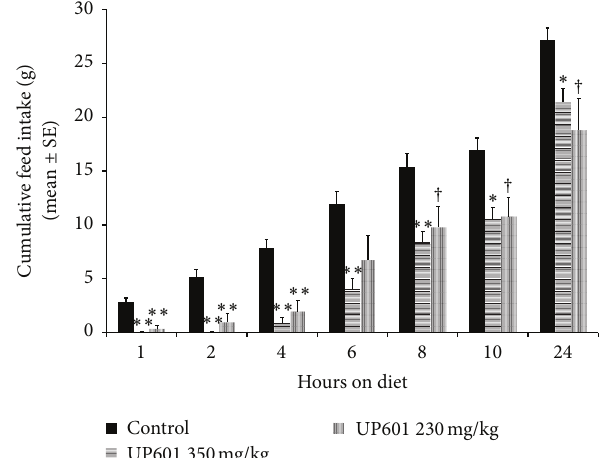
Figure1:HourlycalorieintakebyratstreatedwithUP601at230and 350 mg/kg in the acute food intake study. ∗∗ 𝑃 ≤ 0.0001 ; ∗ 𝑃 ≤ 0.05 .